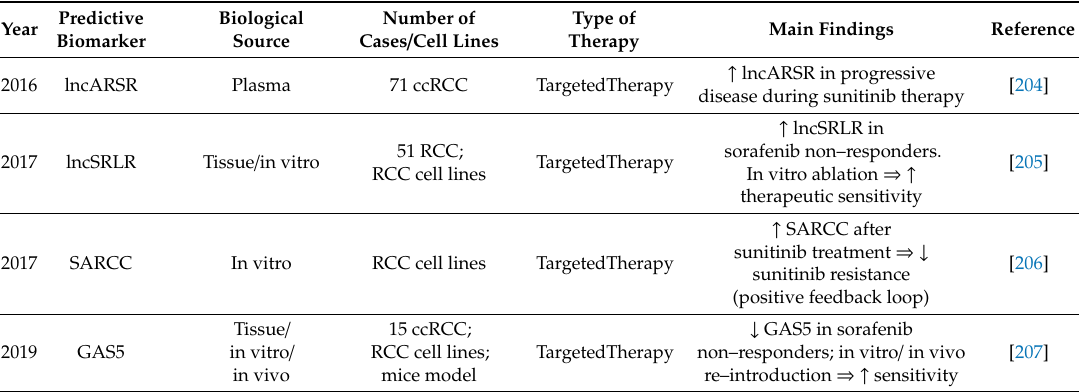
Table 8. Therapy-predictive lncRNAs for RCC in tissue, liquid biopsies, and in vitro